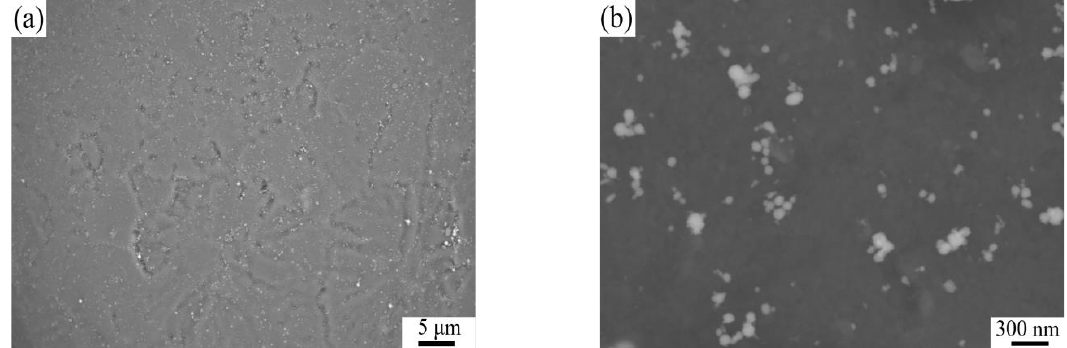
Figure 1. Schematic diagram of TC4/AZ31 composite preparation process. Table 1. Chemical composition of AZ31 alloy (wt.%).